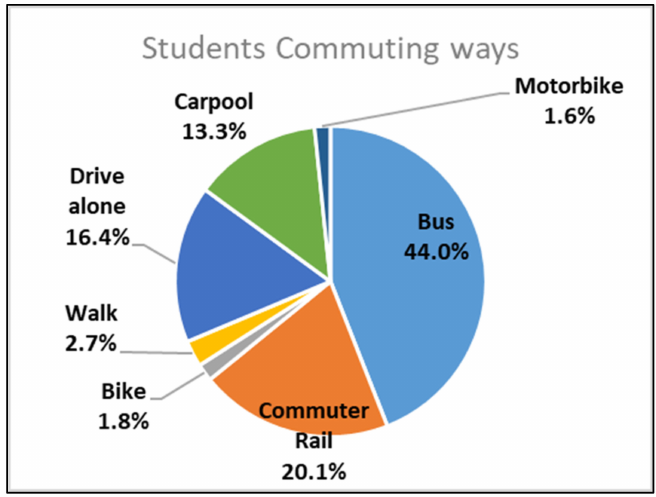
Figure 4. Student commuting